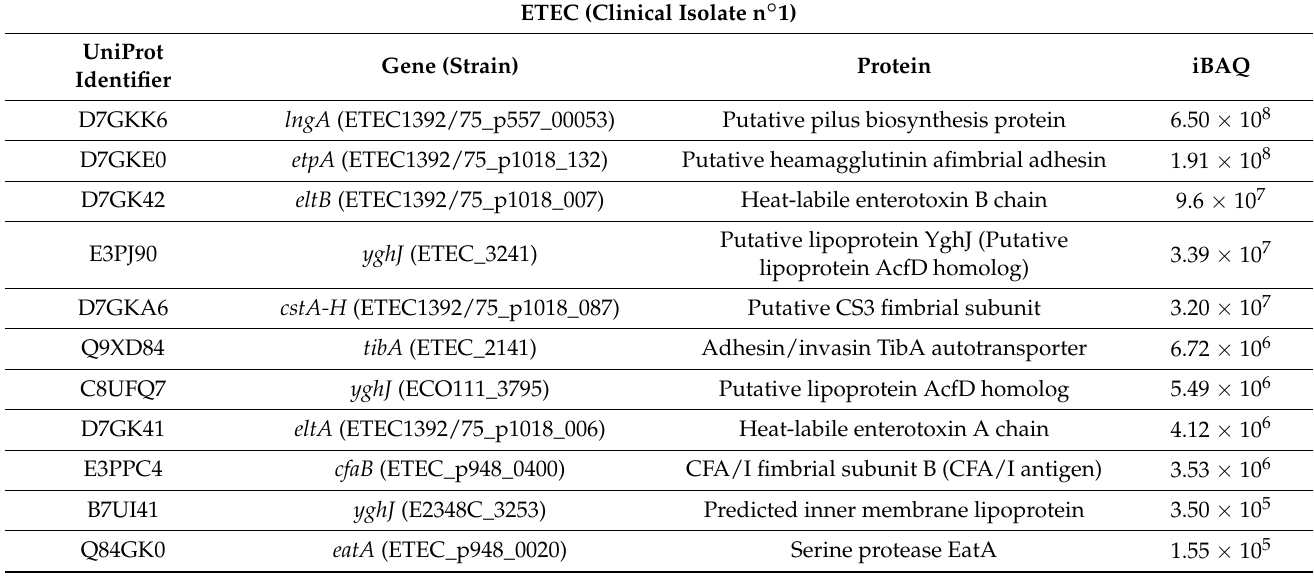
Table 1. Enterotoxigenic Escherichia coli (ETEC) virulence factors identified in outer membrane vesicles (OMV) isolated from the ETEC clinical isolate n ◦ 1. Protein quantification is expressed in iBAQ. ETEC (clinical isolate nº 1)